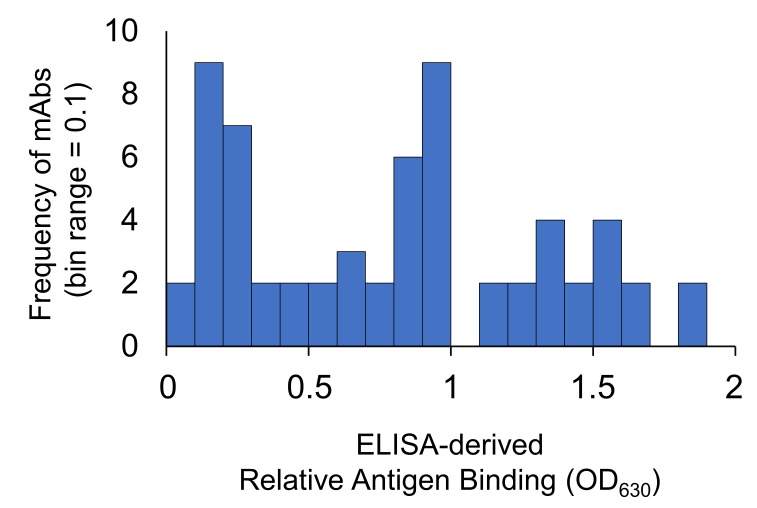
Histogram of relative antigen binding strength for the anti-LigB mAb libraries.Hybridoma supernatants containing individual mAbs were screened for efficient antigen binding using ELISA. The frequency of relative binding strength for both library C and V is depicted for each 0.1 OD630 range. The distribution can be grouped into populations of non-binding mAbs (0 < OD630< 0.5), weak binding mAbs (0.5 < OD630< 1.0), and moderate to high binding mAbs (1.0 < OD630< 2.0). Additional characterization was only pursued for the mAbs with moderate to high binding efficiencies. The division between weak and moderate binding efficiency also corresponded to the average between the lowest and highest OD630 for hybridoma supernatants in the ELISA screen.